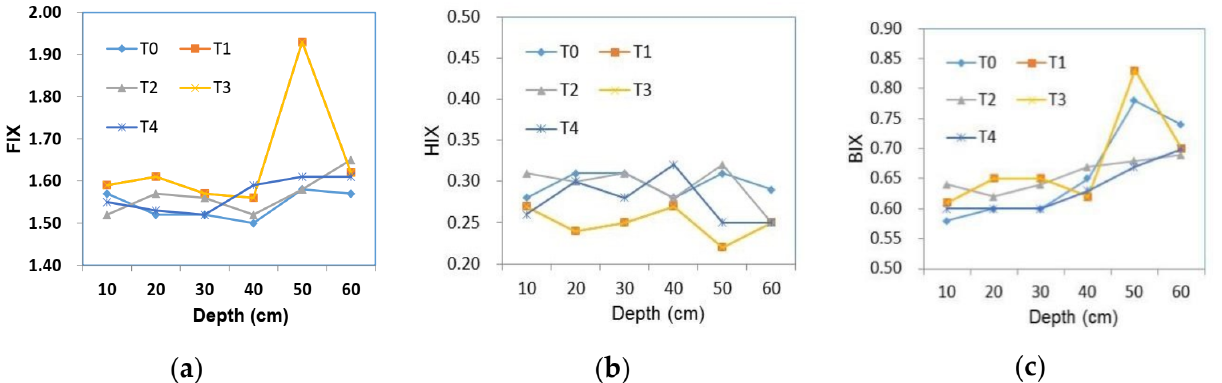
Figure 4. Fluorescence index (FIX), humification index (HIX), and biological index (BIX) of the five treatment groups in the whole soil depth (0–60 cm): ( a ) FIX; ( b ) HIX; ( c ) BIX. The HIX values were around 0.27 (mean value) among different treatment groups. As compared with the decreased HIX values with increasing soil depths in the control (T1) group, the mean HIX values of BC-amended soil in different soil layers were higher as compared with those of NPK-fertilized soil. As expected, the HIX values of the T3